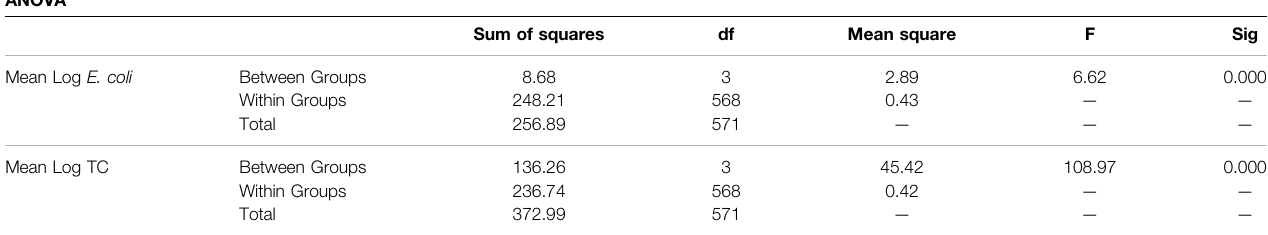
TABLE 2 | Comparison of mean log concentration of microbial load. ANOVA